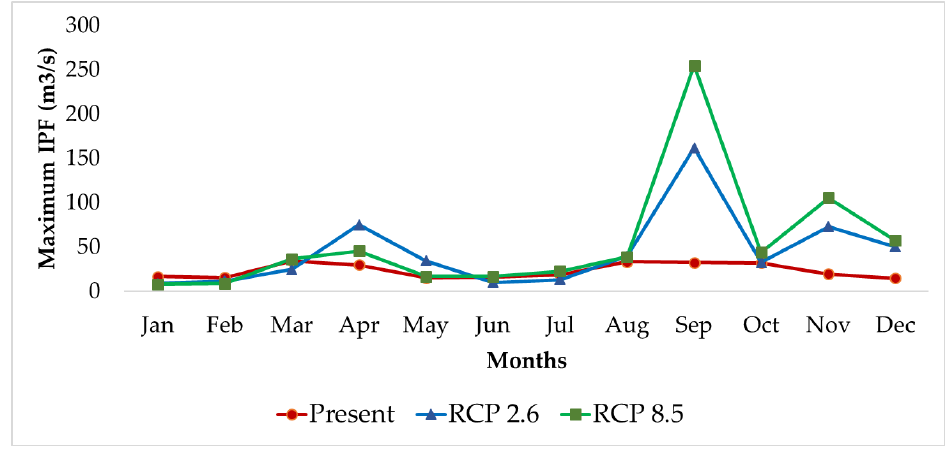
Figure 9. Monthly maximum discharge simulation for present and near future periods.